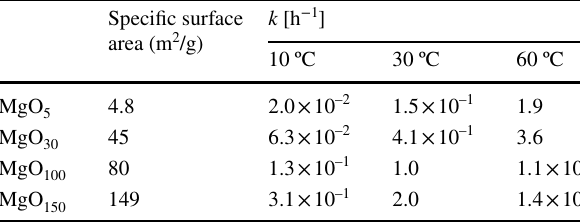
Table 3 Reaction rate constant for boron removal at each temperature for each MgO Specific surface area (m 2 /g)